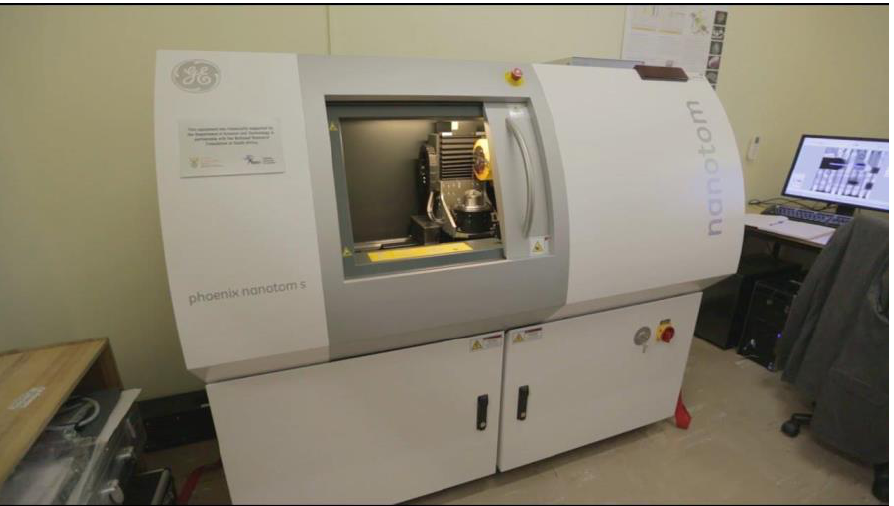
Figure 7. The General Electric Nanotom S CT scanner used to determine the porosity characteristics of the 3D printed and cast concrete in this study.